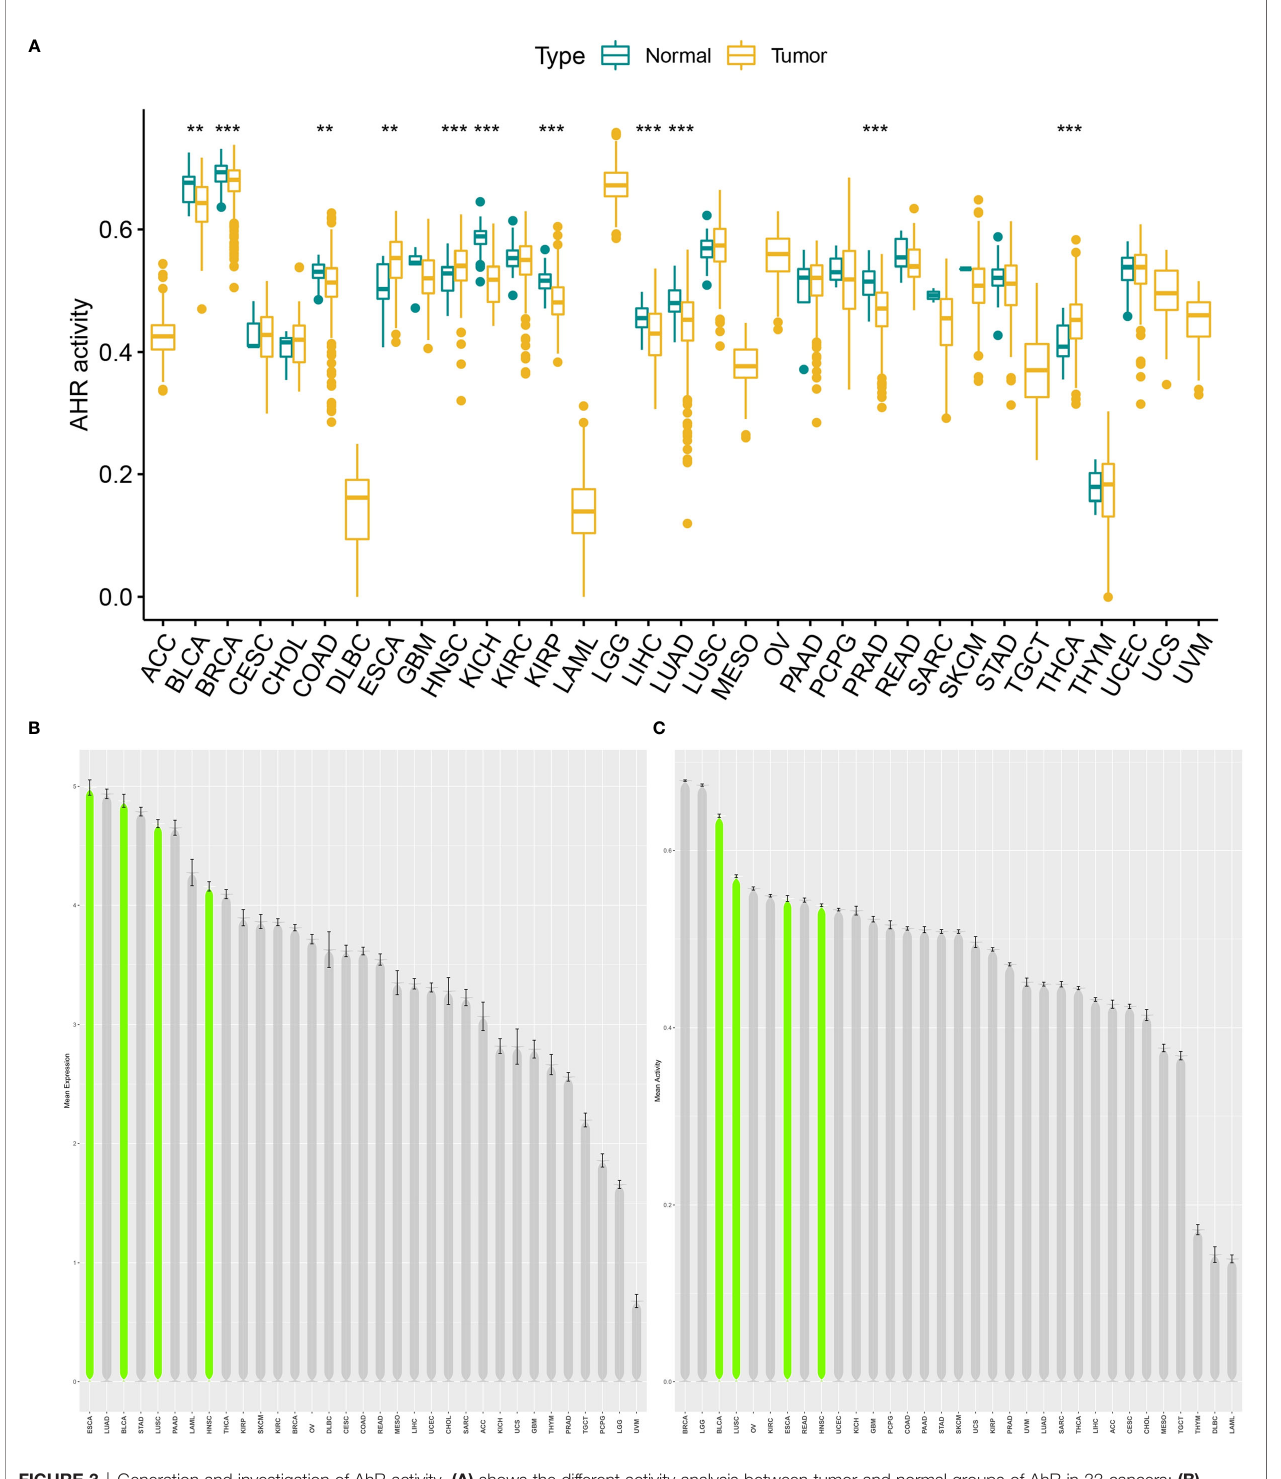
FIGURE 3 | Generation and investigation of AhR activity. (A) shows the different activity analysis between tumor and normal groups of AhR in 33 cancers; (B) shows the mean expression of AhR in 33 cancers (from high to low); (C) shows the mean activity of AhR in 33 cancers (from high to low). “ ** ” indicates p < 0.01 and “ *** ” indicates p <